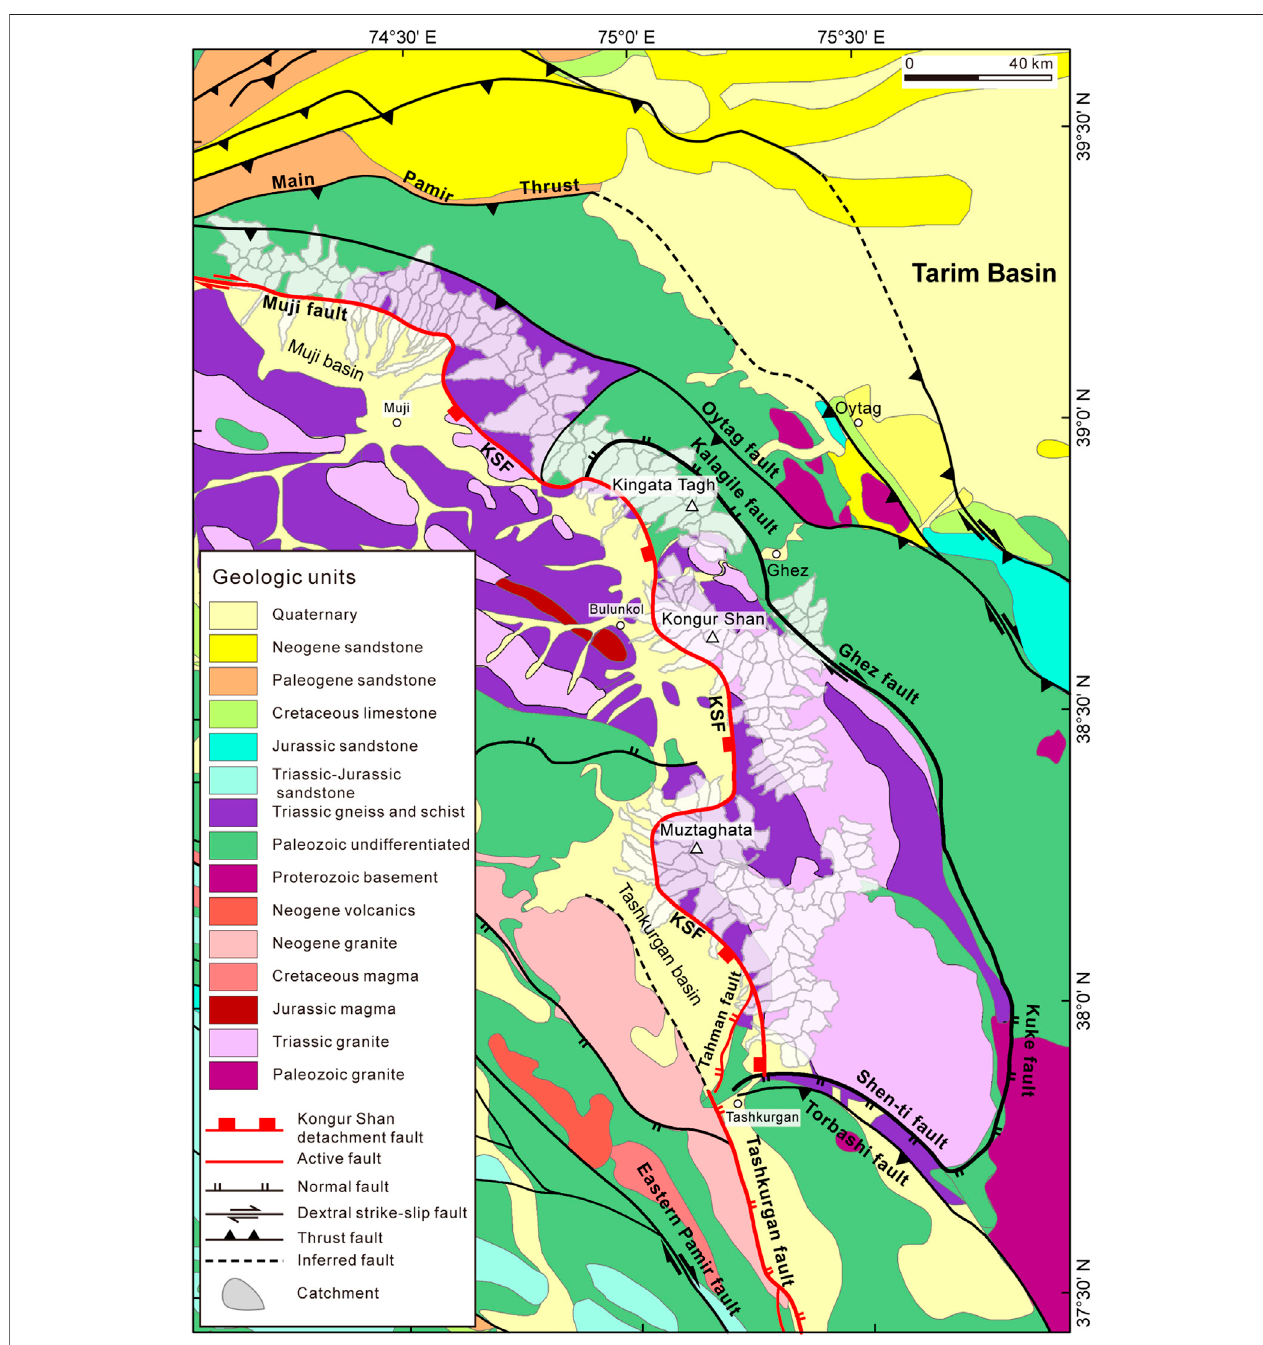
FIGURE 2 | Simpli fi ed geological map of the eastern Pamir region, modi fi ed after Cao et al. (2013a), Cowgill (2010), and Robinson et al. (2007), with major lithologic units.